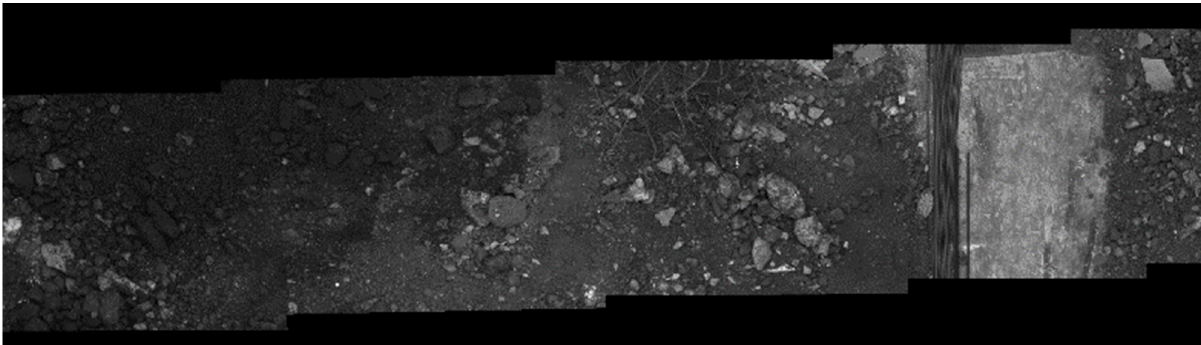
Figure 29. OCPSI mode: effective image.